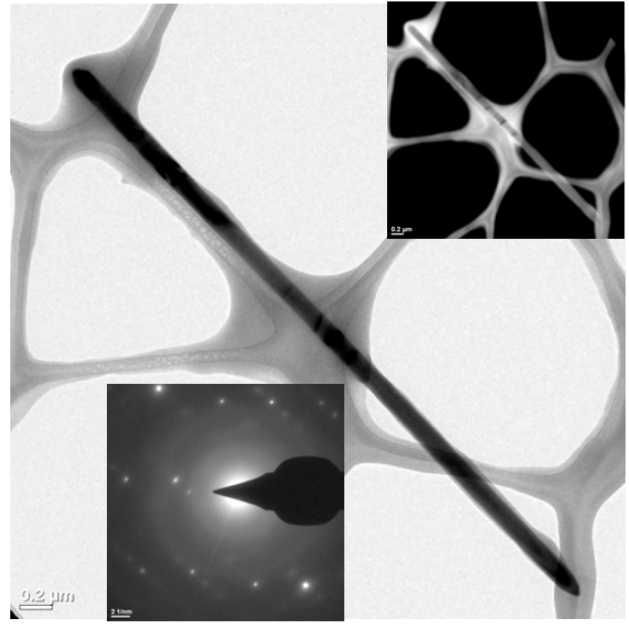
Figure 3. TEM images of an isolated ZnO nanorod.